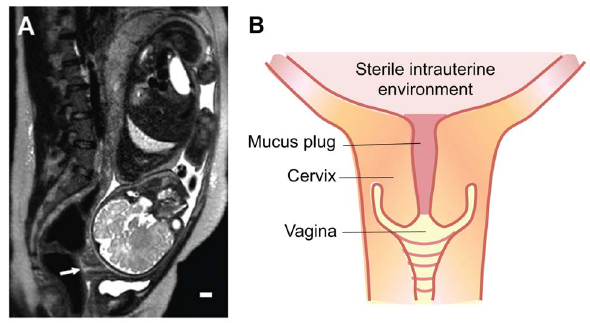
Figure 1. (A) MRI image of patient at 34 weeks gestation. Arrow points to cervical mucus plug. Scale bar: 1 cm. (B) Diagram of the cervical mucus plug in situ.